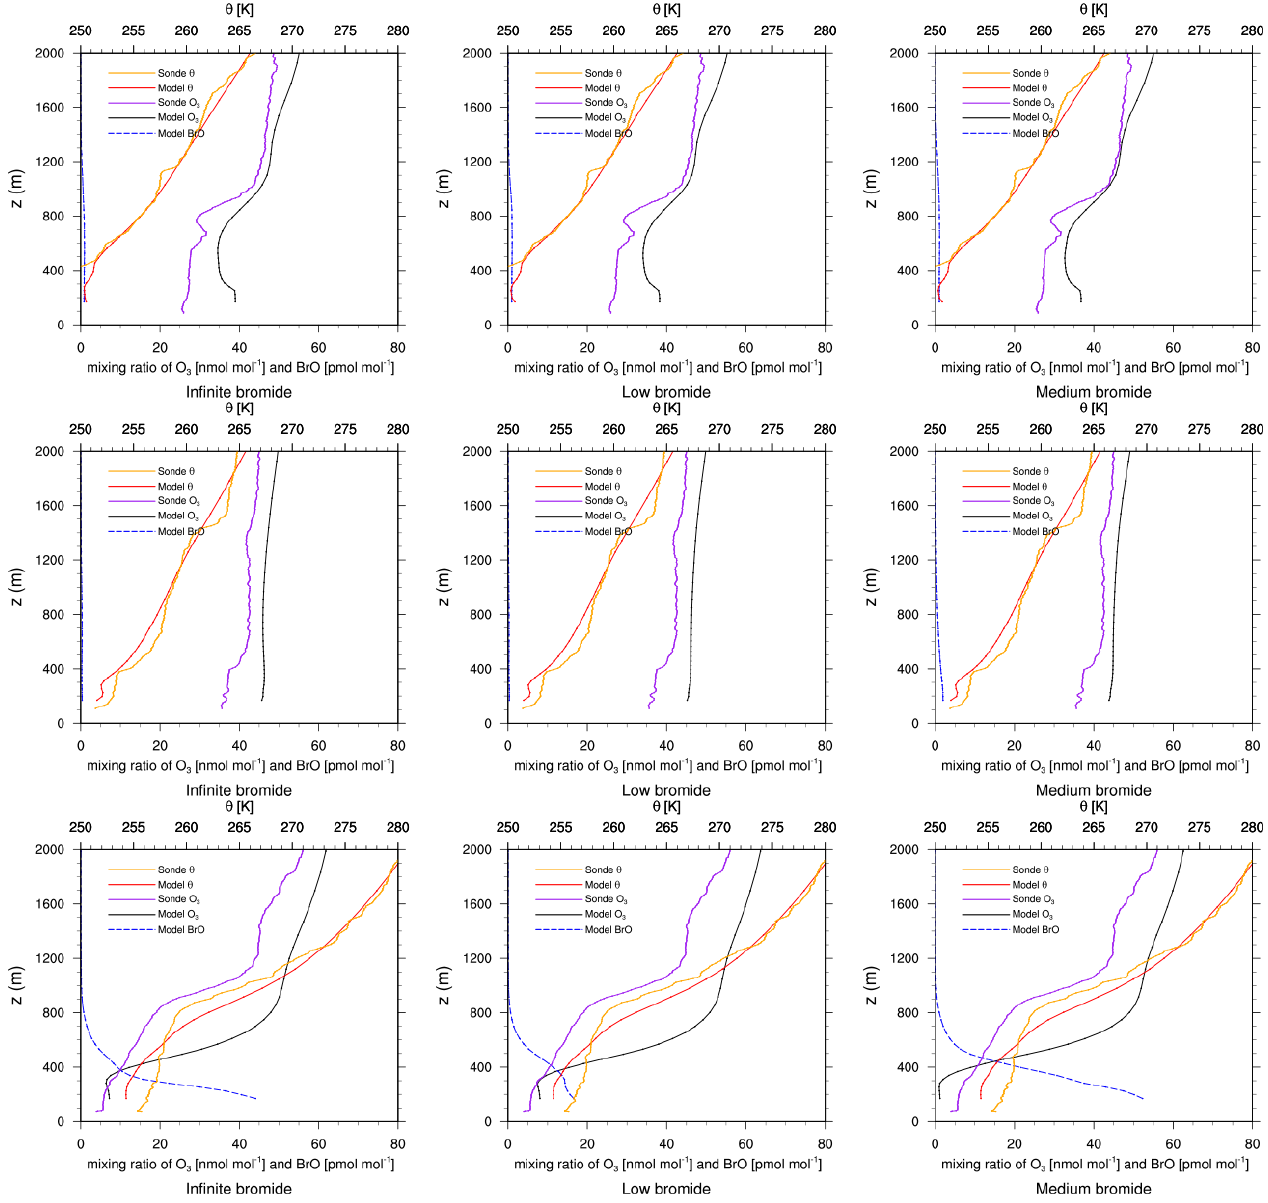
Figure 6. Modeled BrO mixing ratio as well as potential temperature θ and ozone mixing ratios from simulations and from ozone sonde flights against height at Alert. Columns: infinite FY ice bromide (left), low bromide (center), medium bromide (right). Rows: 6 March 2019 (top), 13 March 2019 (center), 3 April 2019